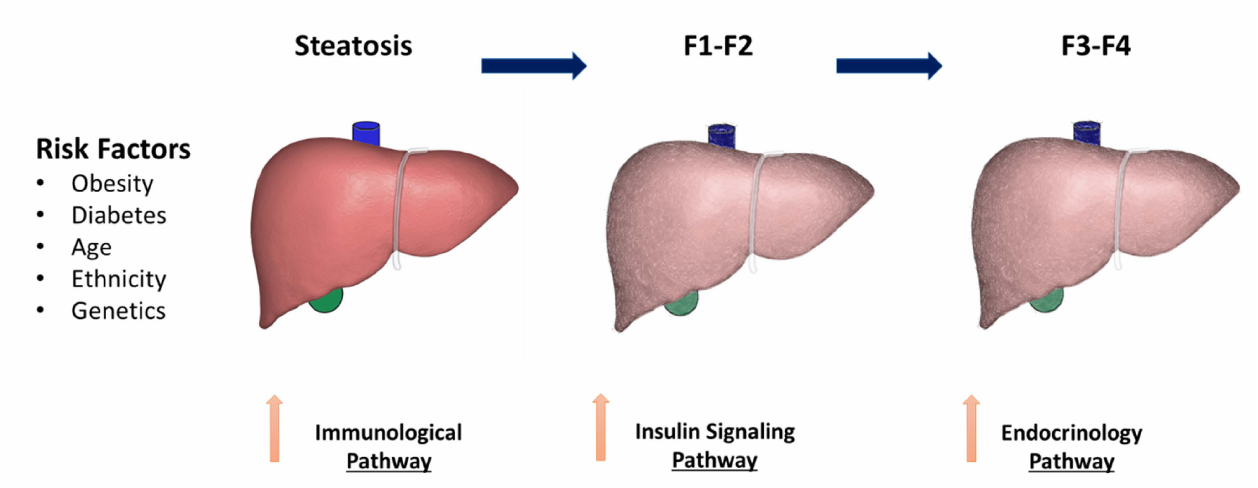
Figure 1. Risk factors and proposed mechanisms for non-alcohol steatosis (NASH) progressive liver